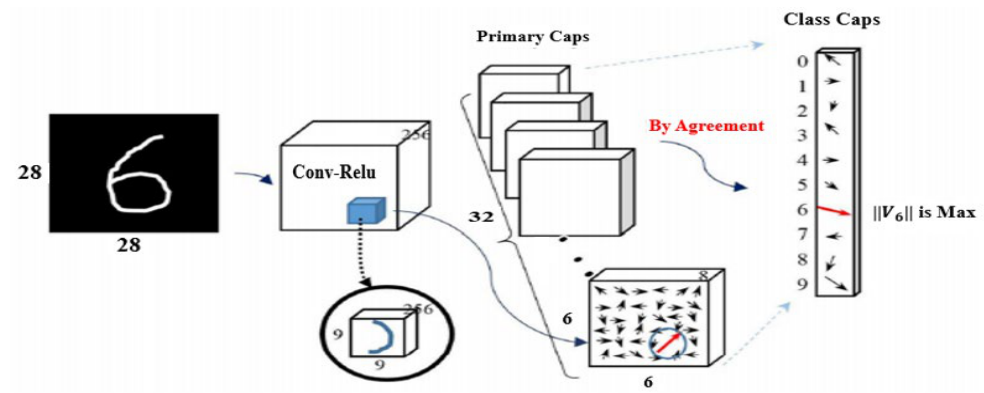
Figure 1. Capsule network architecture.